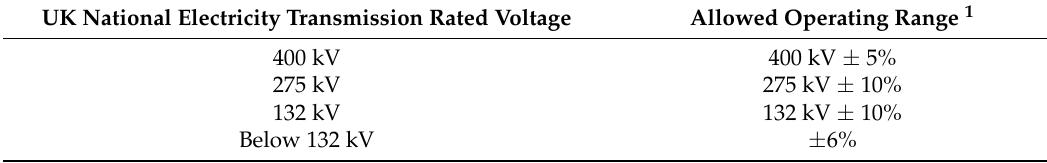
Table 1. Normal operating voltage ranges of the UK national electricity transmission system [1,10].